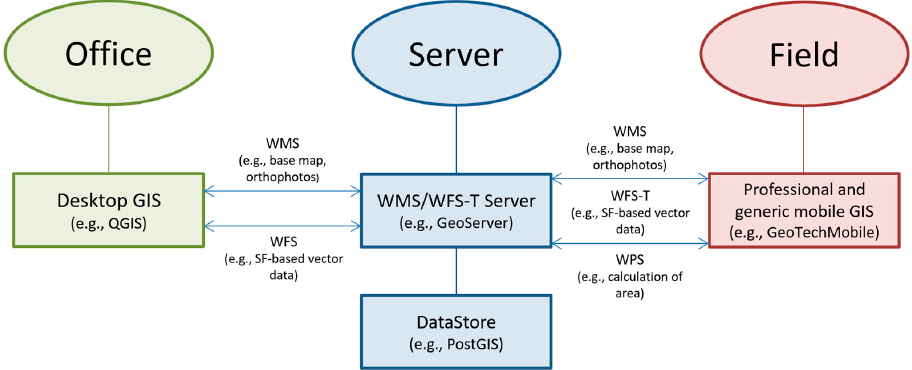
Figure 3. Overview of the workflow between office and field.